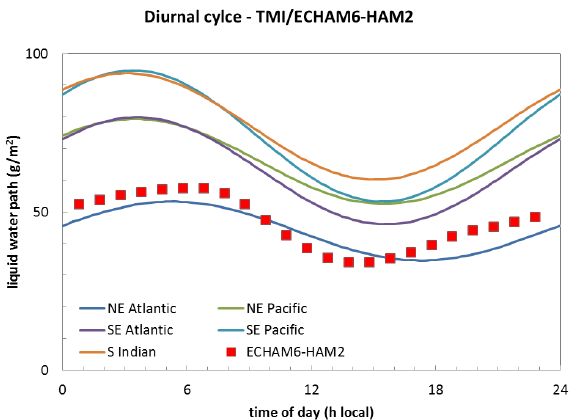
Figure 9. Diurnal cycle of liquid water path from TMI microwave radiometer data in different regions in 1999–2000 and ECHAM6- HAM2 in the stratocumulus regime in October